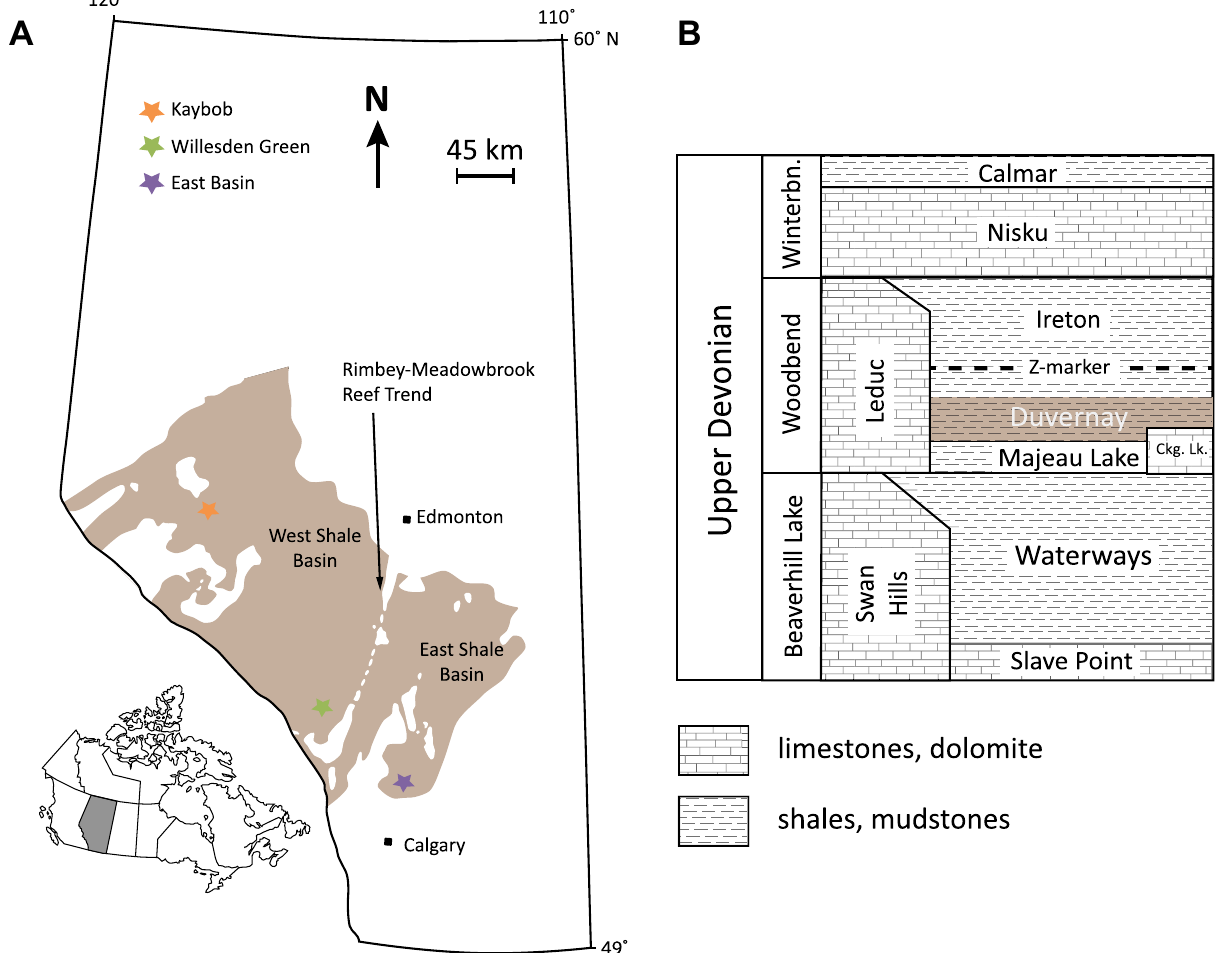
Figure 1. ( A ) Map of Alberta with extent of the subsurface Duvernay Formation. modified from the Geological Atlas of the Western Canada Sedimentary Basin 28 . ( B ) Simplified stratigraphy of the Duvernay Formation in Alberta, Canada and the location of three drill cores used in this